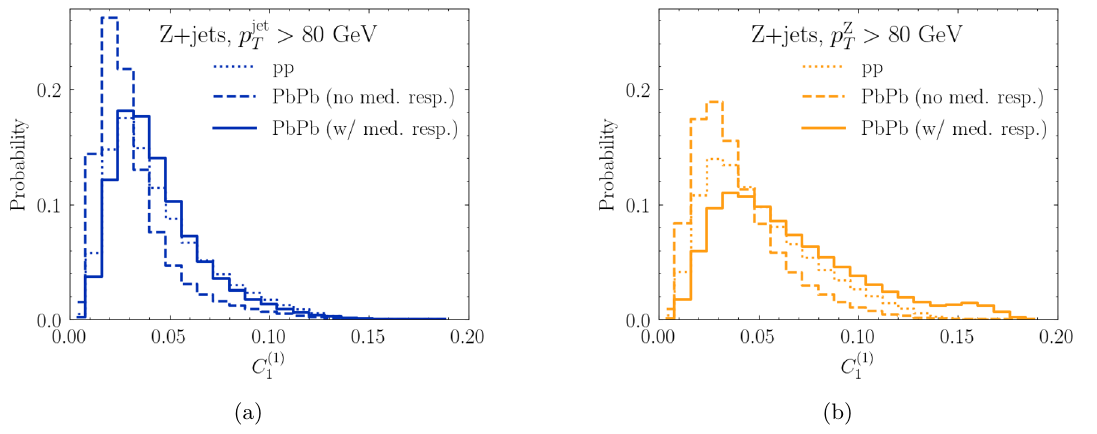
Figure 7. C (1) distributions, (a) for jets with p T above 80 GeV and (b) for jets recoiling against a Z 1 boson with p T above 80 GeV, in vacuum (dotted), in heavy ion collisions without medium response (dashed), and in heavy ion collisions with medium response